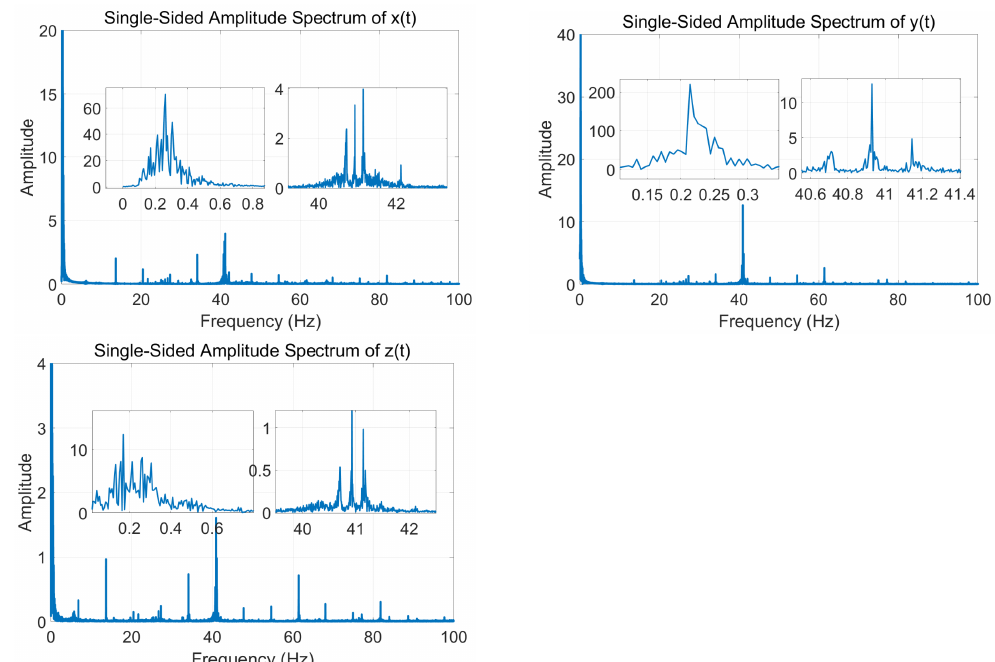
Figure 6. Spectrum analysis diagram of the three-axis accelerometer under dynamic